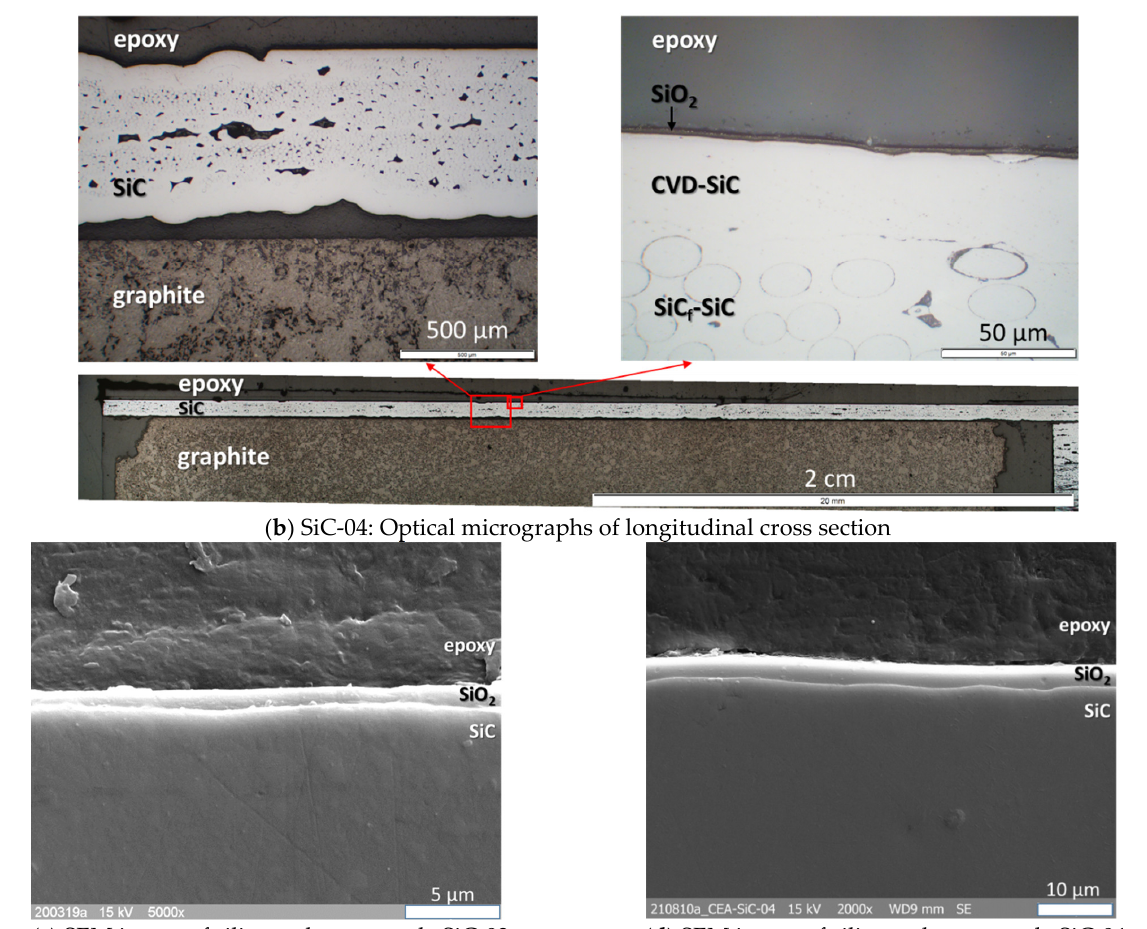
Figure 10. OM ( a , b ) and SEM ( c , d ) images of sample cross sections after 1 h (SiC-03) and 3 h (SiC-04) steam oxidation at 1700 °C.